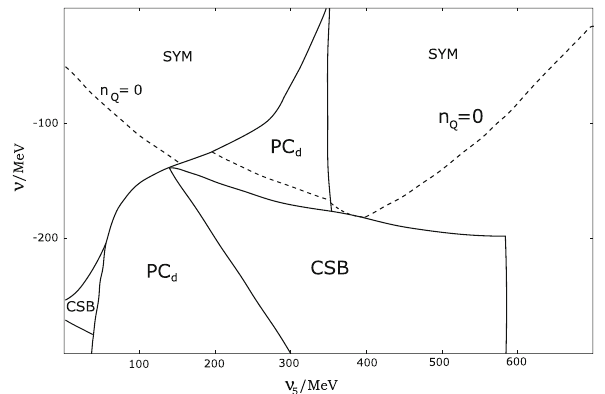
Fig. 7 The (ν 5 ,ν) -phase diagram of β -equilibrium quark matter (see the models (7), (8)) at μ = 350 MeV and μ 5 = 150 MeV in the chiral limit, m 0 = 0. All the notations are the same as in Figs. 1, 2 and 3